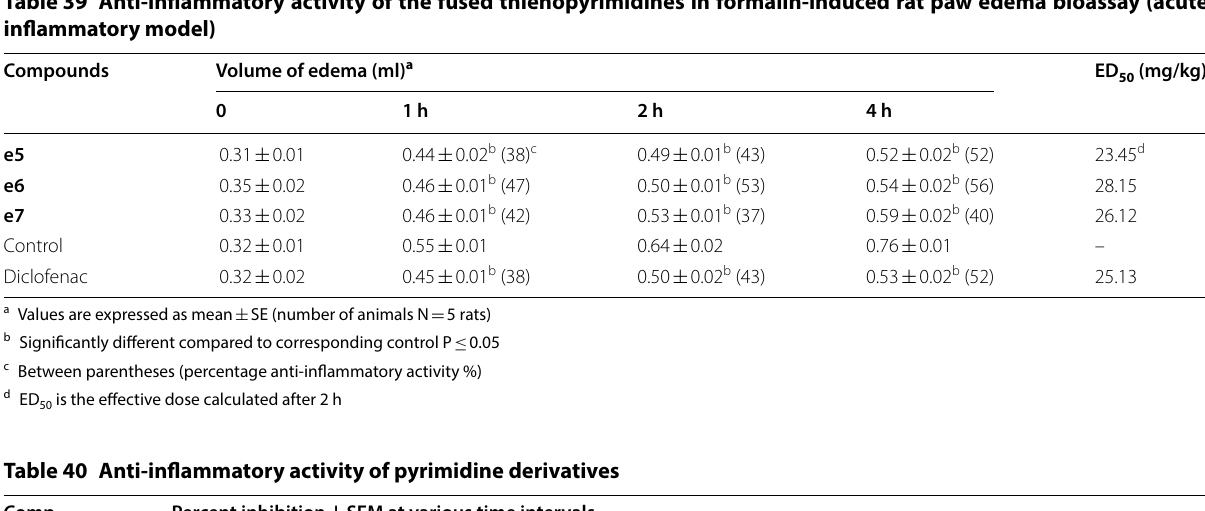
SEM ( n 6). * P < 0.01 compared to saline control group. One-way ANOVA, Dunnett’s t test. Dosage: Ibuprofen-10 mg/kg and test ± =